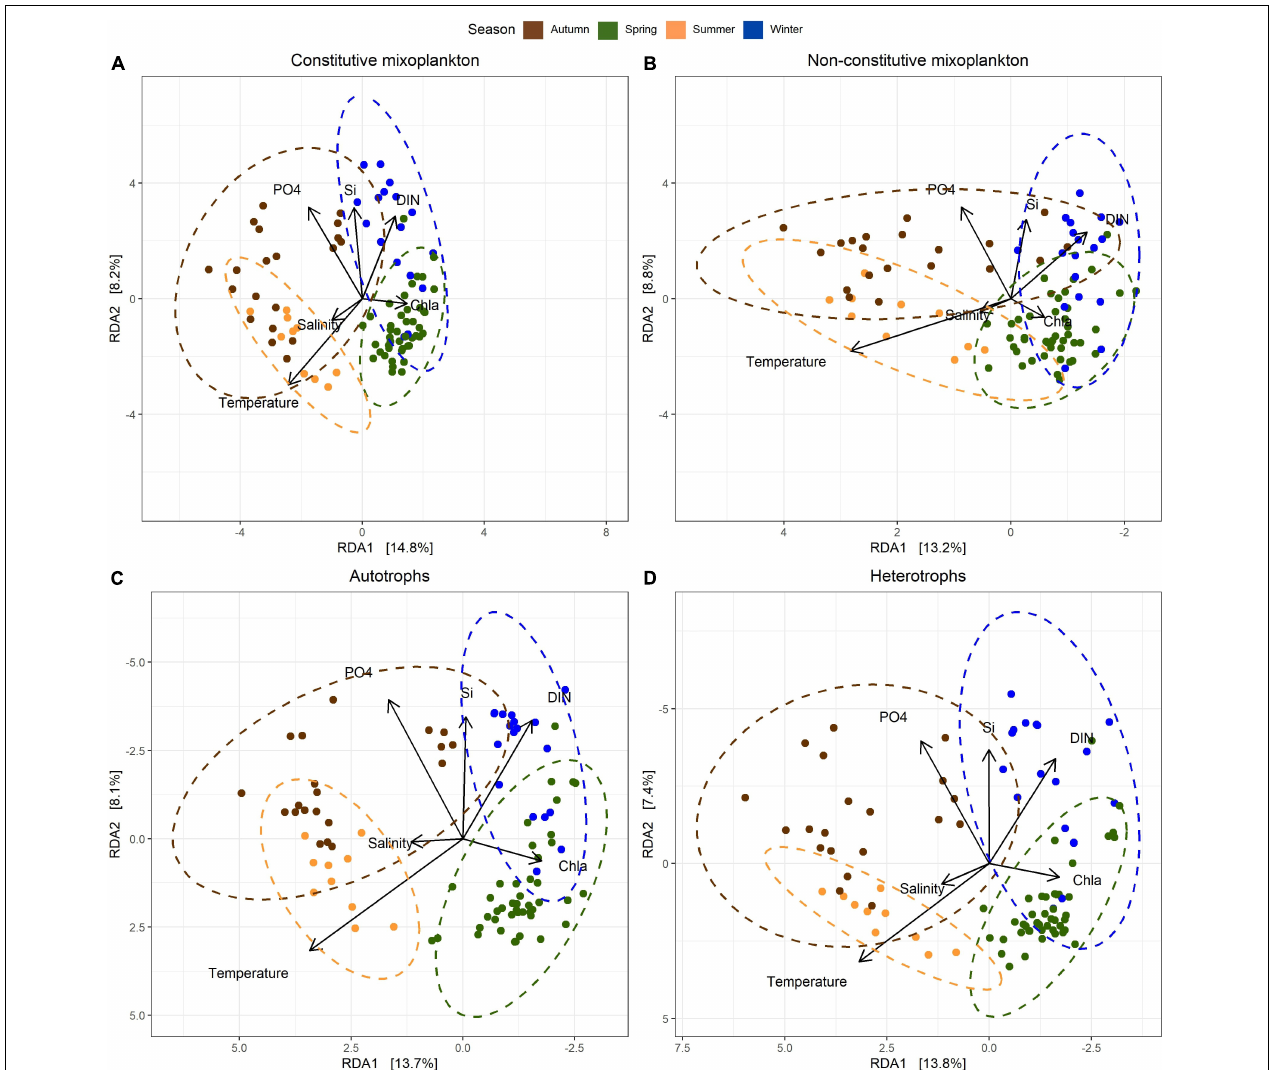
FIGURE 6 | Redundancy analysis (RDA) of clr-transformed ASV counts were performed independently for each of the trophic strategies studied: (A) constitutive mixoplankton, (B) non-constitutive mixoplankton, (C) autotrophs, and (D) heterotrophs. Contextual environmental data were used as explanatory variables, represented as arrows. Vector lengths correspond to relative importance. Samples clusters were performed according to established seasons. Note reverse axis in (B) ( x axis), (C,D) ( x and y